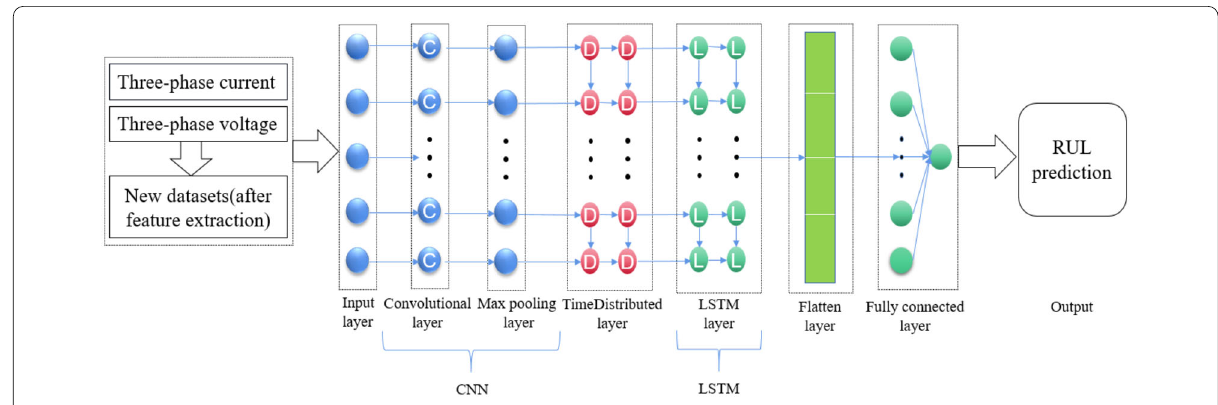
Figure 5 the structure of